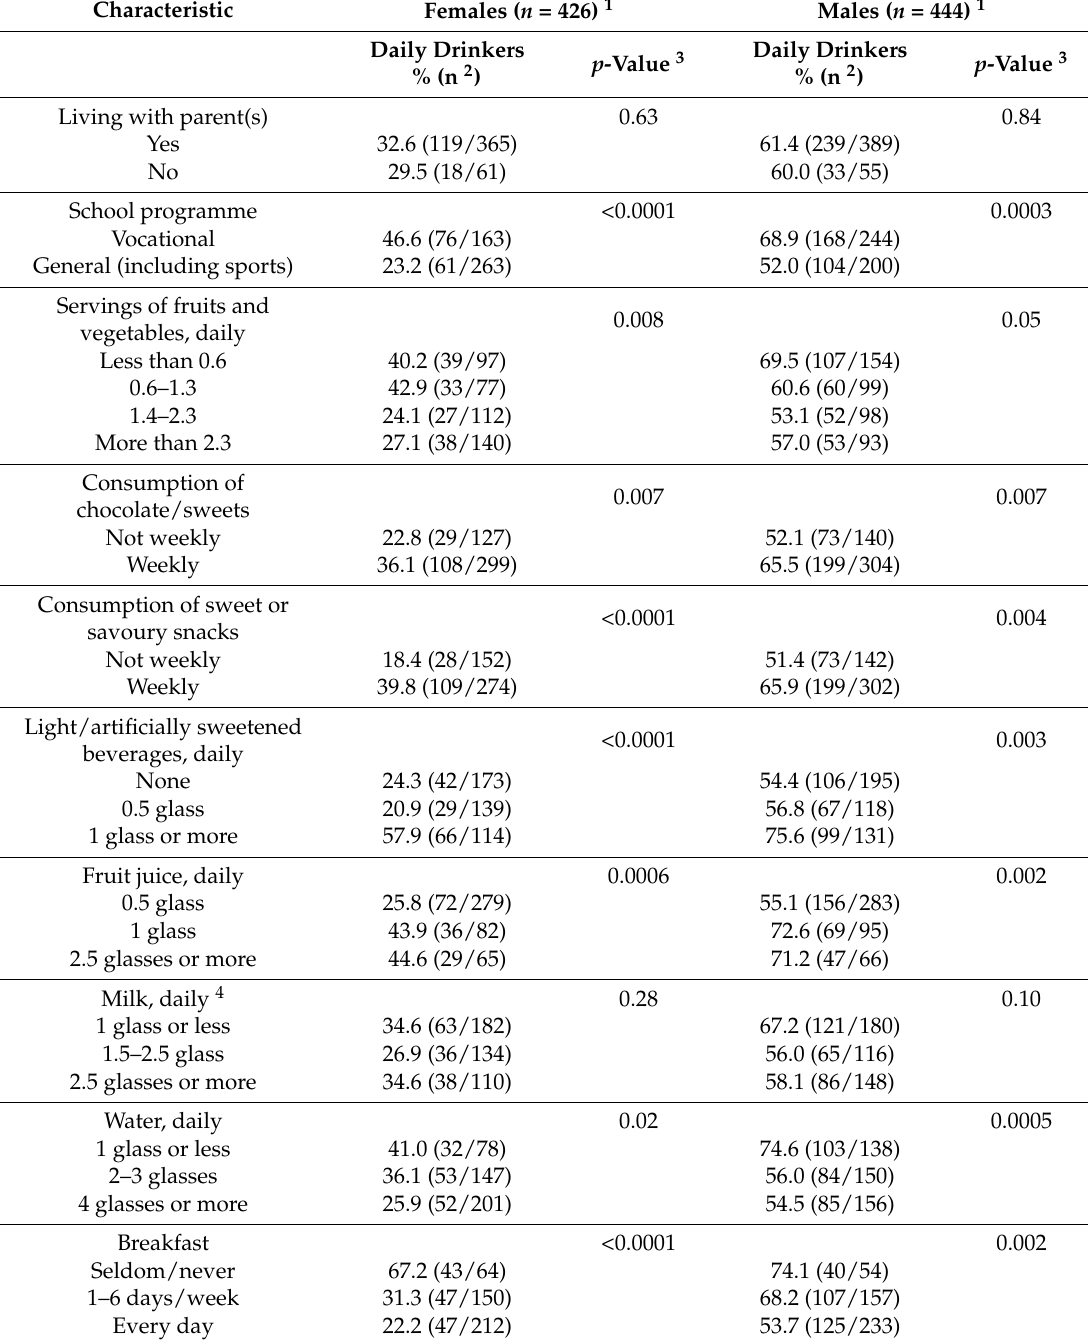
Table 2. Daily drinkers of sugar-sweetened beverages according to demographic, dietary and lifestyle characteristics, by sex in the Tromsø study: Fit Futures